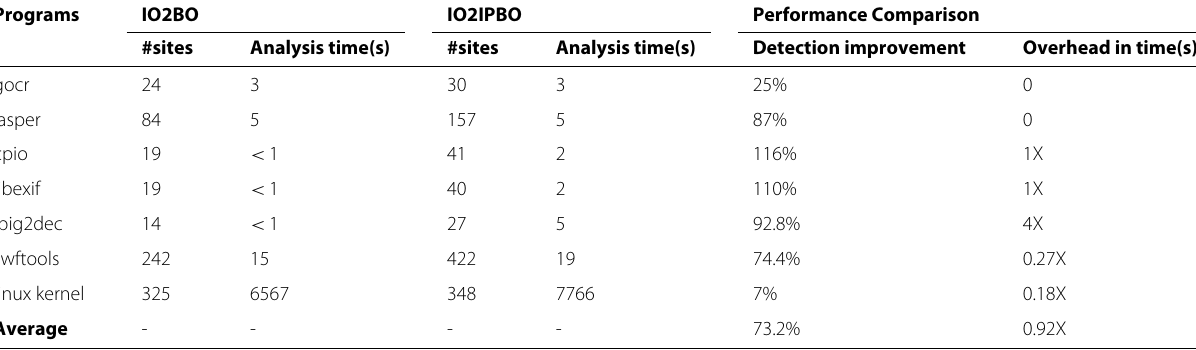
Table 8 Comparison between IO2BO and IO2IPBO